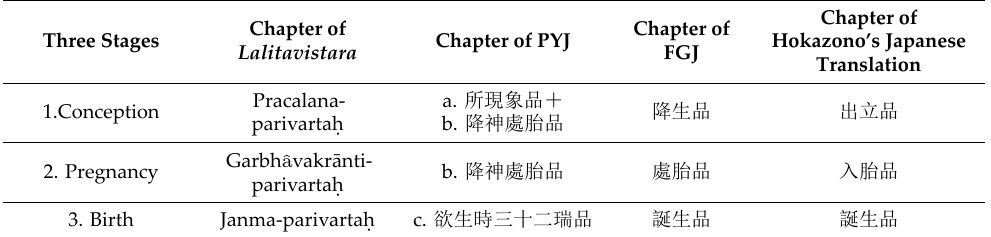
Table 1. The three stages of the Buddha’s birth in the Lalitavistara and their Chinese translations (PYJ and